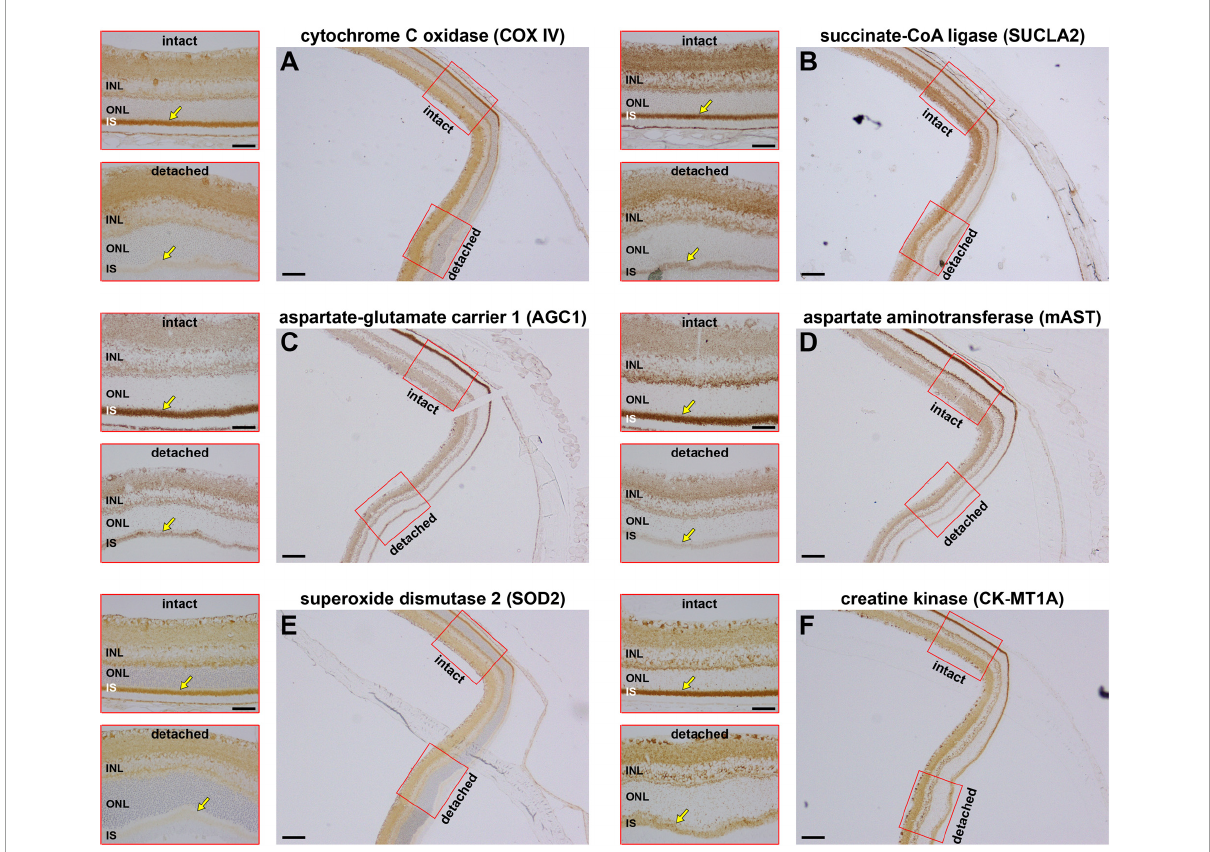
FIGURE3 Effect of retinal detachment on expression of six mitochondrial enzymes within the same 3 days detached retina. (A) Cytochrome C oxidase (COX IV). (B) Succinate-CoA ligase (SUCLA2). (C) Aspartate-glutamate carrier 1 (AGC1). (D) Mitochondrial aspartate aminotransferase (mAST). (E) Mitochondrial superoxide dismutase (SOD2). (F) Mitochondrial creatine kinase (CK-MT1A). Scale bar: overviews = 150 µ m; insets = 60 µ m. INL, inner nuclear layer; SI, inner segments; ONL, outer nuclear